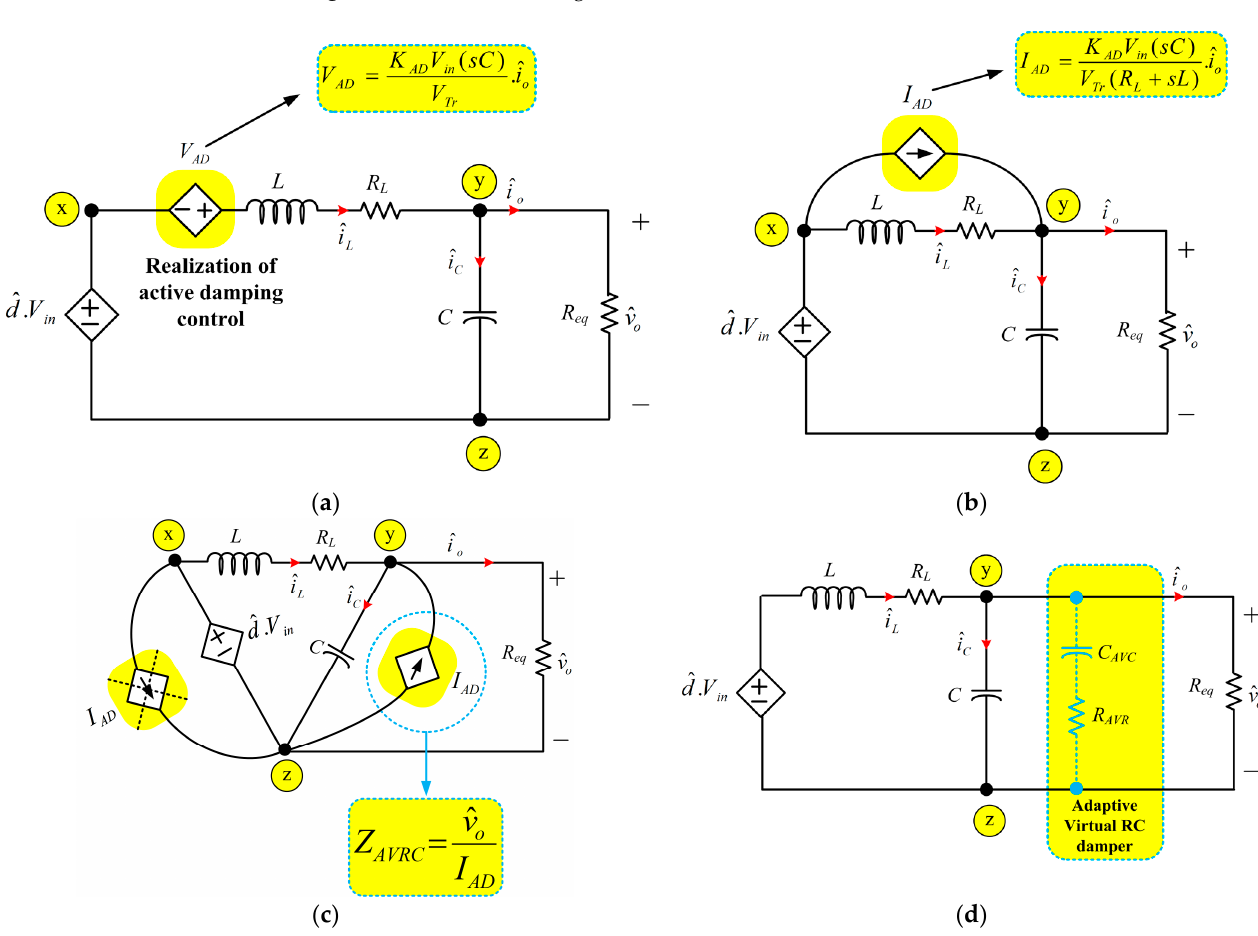
Figure 12. ( a ) Small-signal averaged model; ( b ) analytical interpretation of (a); ( c ) analytical repre- sented in Figure 12b; ( d ) physical idea of AVRC damping [87].